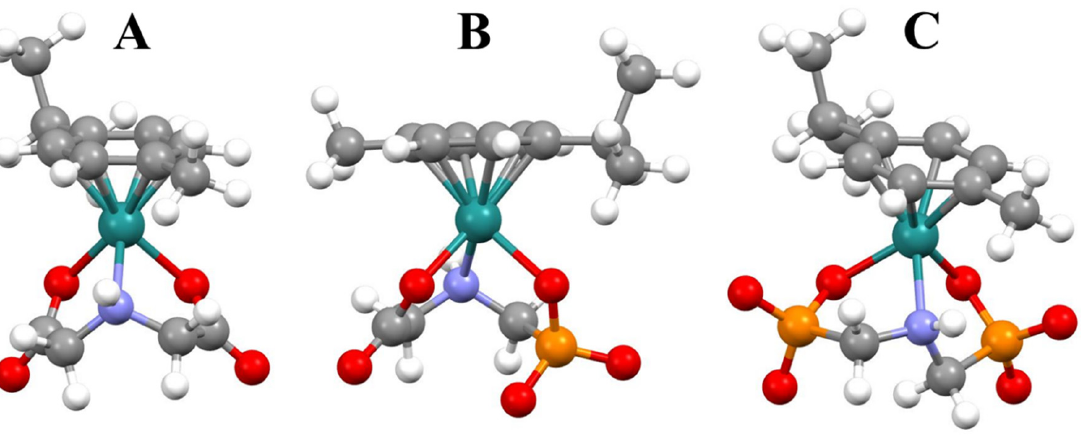
Figure 4. The DFT optimized structure of the [( η 6 - p -cym)Ru(Ida)] ( A ), [( η 6 - p -cym)Ru(IdaP)] − ( B ), and [( η 6 - p -cym)Ru(Ida2P)] 2 − ( C ). Table 3. Optimized bond lengths (Å) and angles ( ◦ ) for the [( η 6 - p -cym)Ru(Ida)], [( η 6 - p - cym)Ru(IdaP)] − , and [( η 6 - p -cym)Ru(Ida2P)] 2 − complexes. Bond